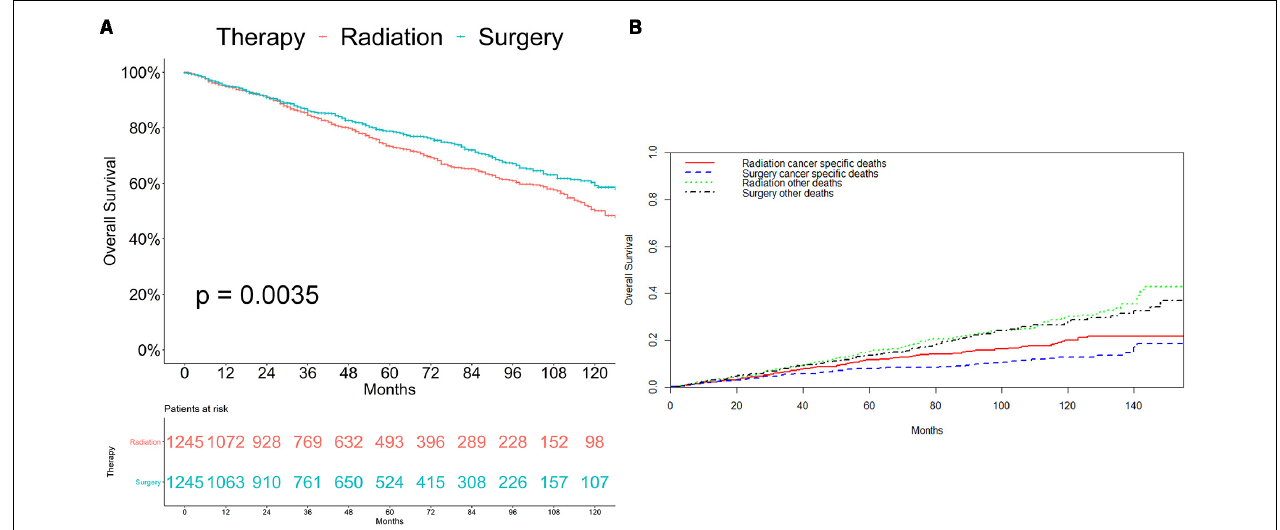
FIGURE 2 | Survival analyses for patients with radiotherapy and with surgery (A) Kaplan-Meier method. (B) Competing risk analysis.